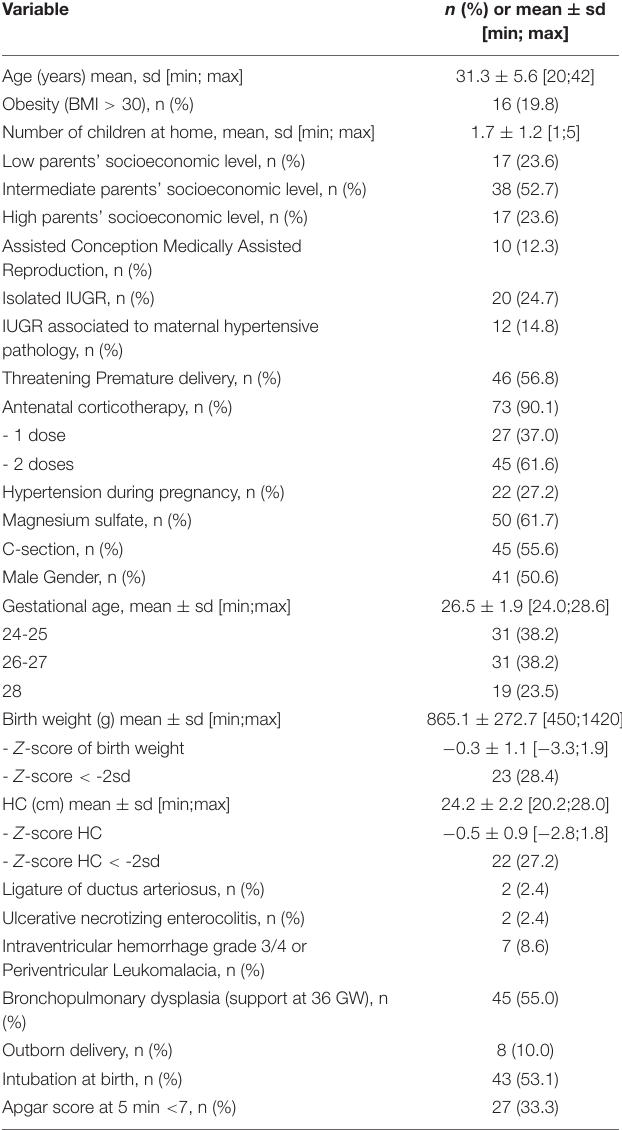
TABLE 1 | Selected baseline characteristics of the preterm children included in the cohort.